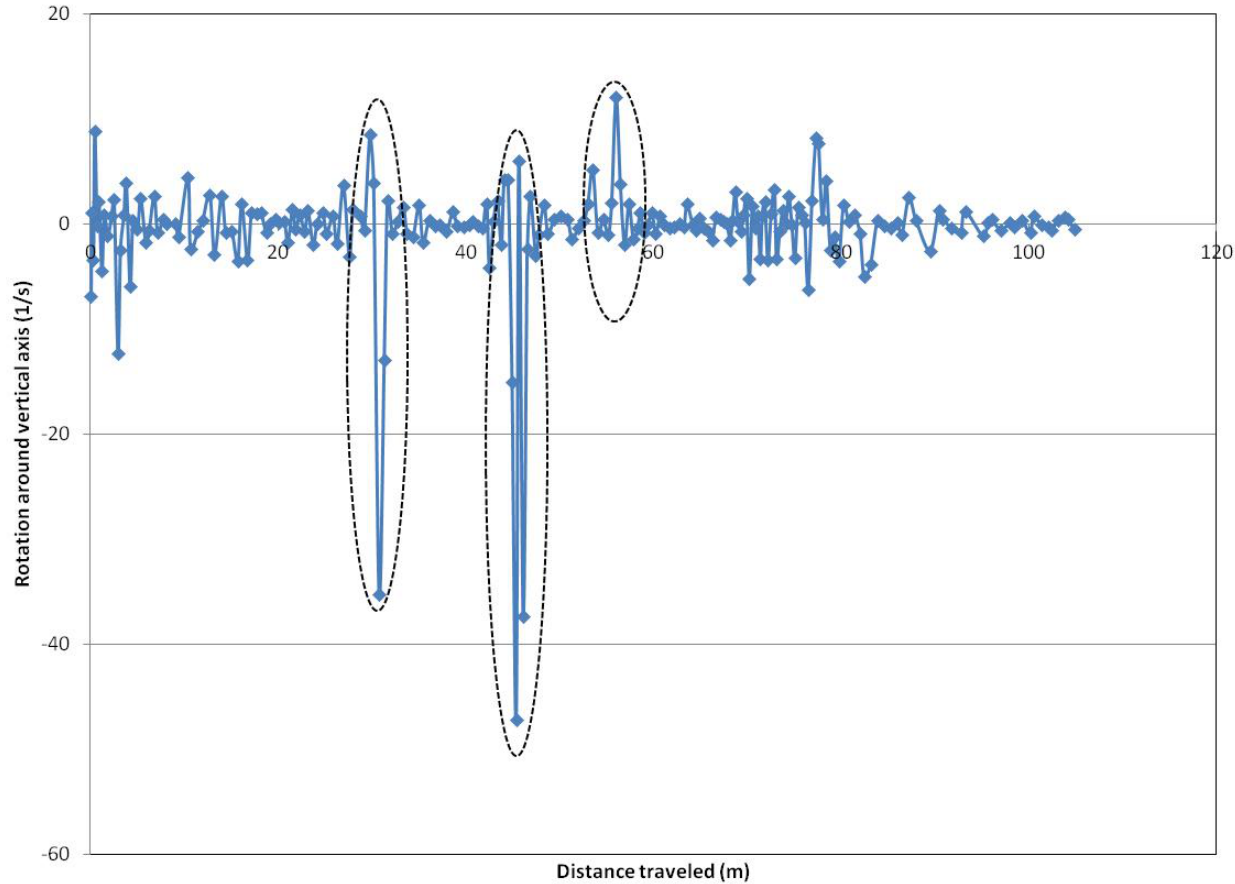
Figure 4. Rotation around the vertical axis along the transect located approximately 40 m downstream of the buoy. Dashed lines indicate zones of great changes. Projected DDD apex and buoy locations coincide with the zone of maximum change. Minimum DDD